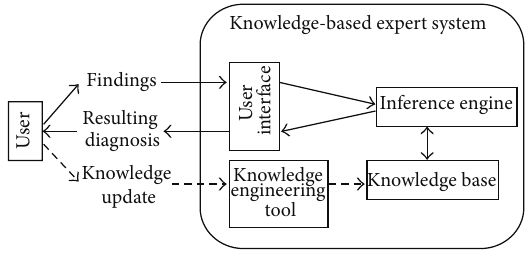
Figure 2: Typical structure of a knowledge-based expert system. Based on Buchanan [3], the user interface allows the nonexpert to enter the symptoms and findings [3] and presents the diagnostic output. The knowledge base provides the knowledge. Different ways of representation, such as rules, models, or cases, can be chosen. The inference engine examines the knowledge base and produces reasoning [15]. The knowledge engineering tool allows for changing or enlarging the knowledge base by adding further rules, cases, or models [7]. There may also be an explaining component, which illustrates the diagnostic process and which gives a rationale